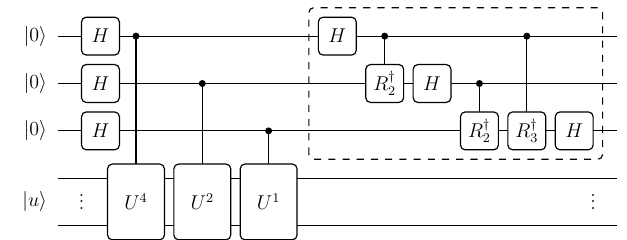
FIG. 16. An illustration of three-qubit quantum phase estima- tion using QSP, in the simplified case when d = 1, with gates slid along wires to highlight the three-qubit inverse QFT circuit which emerges (gates in dotted rectangular